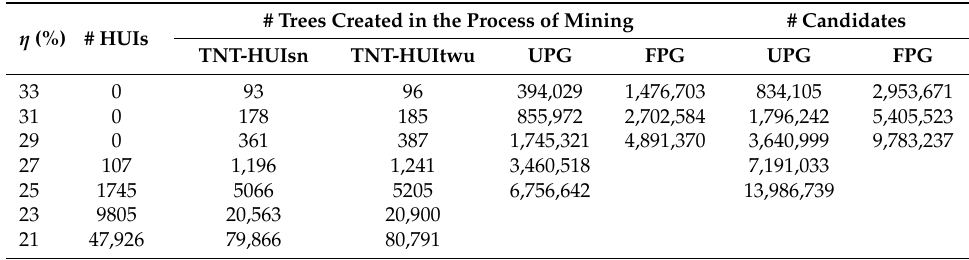
Table 4. Details analysis on the dataset chess.